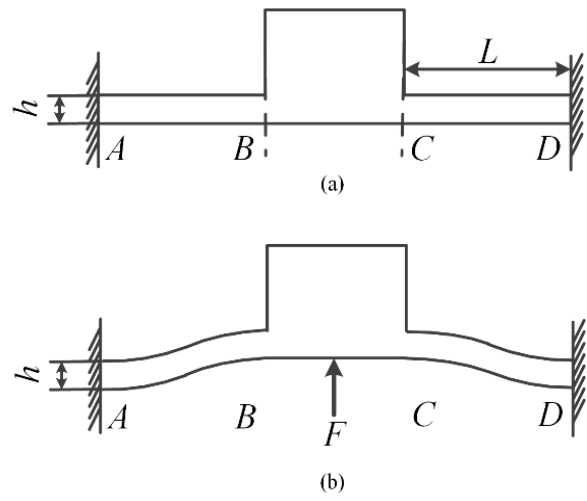
Figure 3. Schematic of the flexure hinges to adjust friction force: ( a ) the structure of flexure hinge; ( b ) force diagram of the flexure hinge. Reproduced with permission from